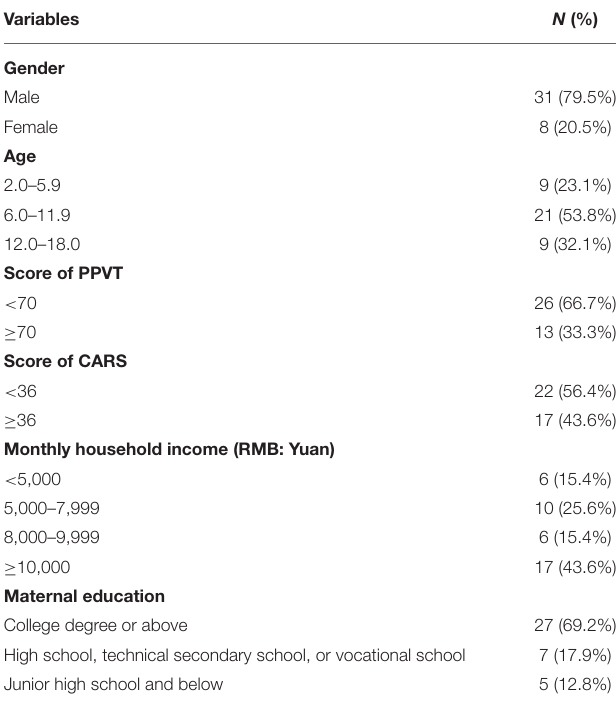
TABLE 1 | Demographic characteristics of autism spectrum disorder children ( n =